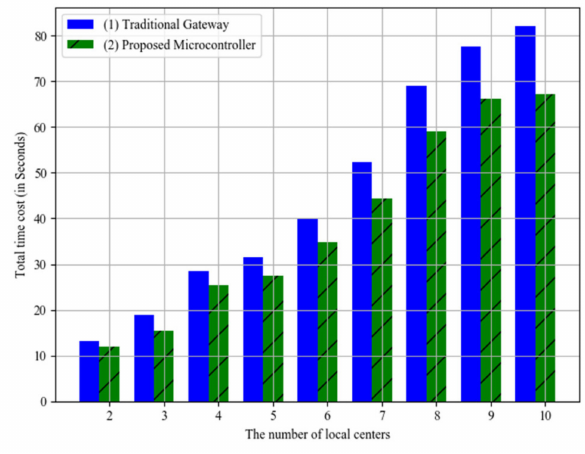
Figure 16. E ffi ciency comparations with traditional